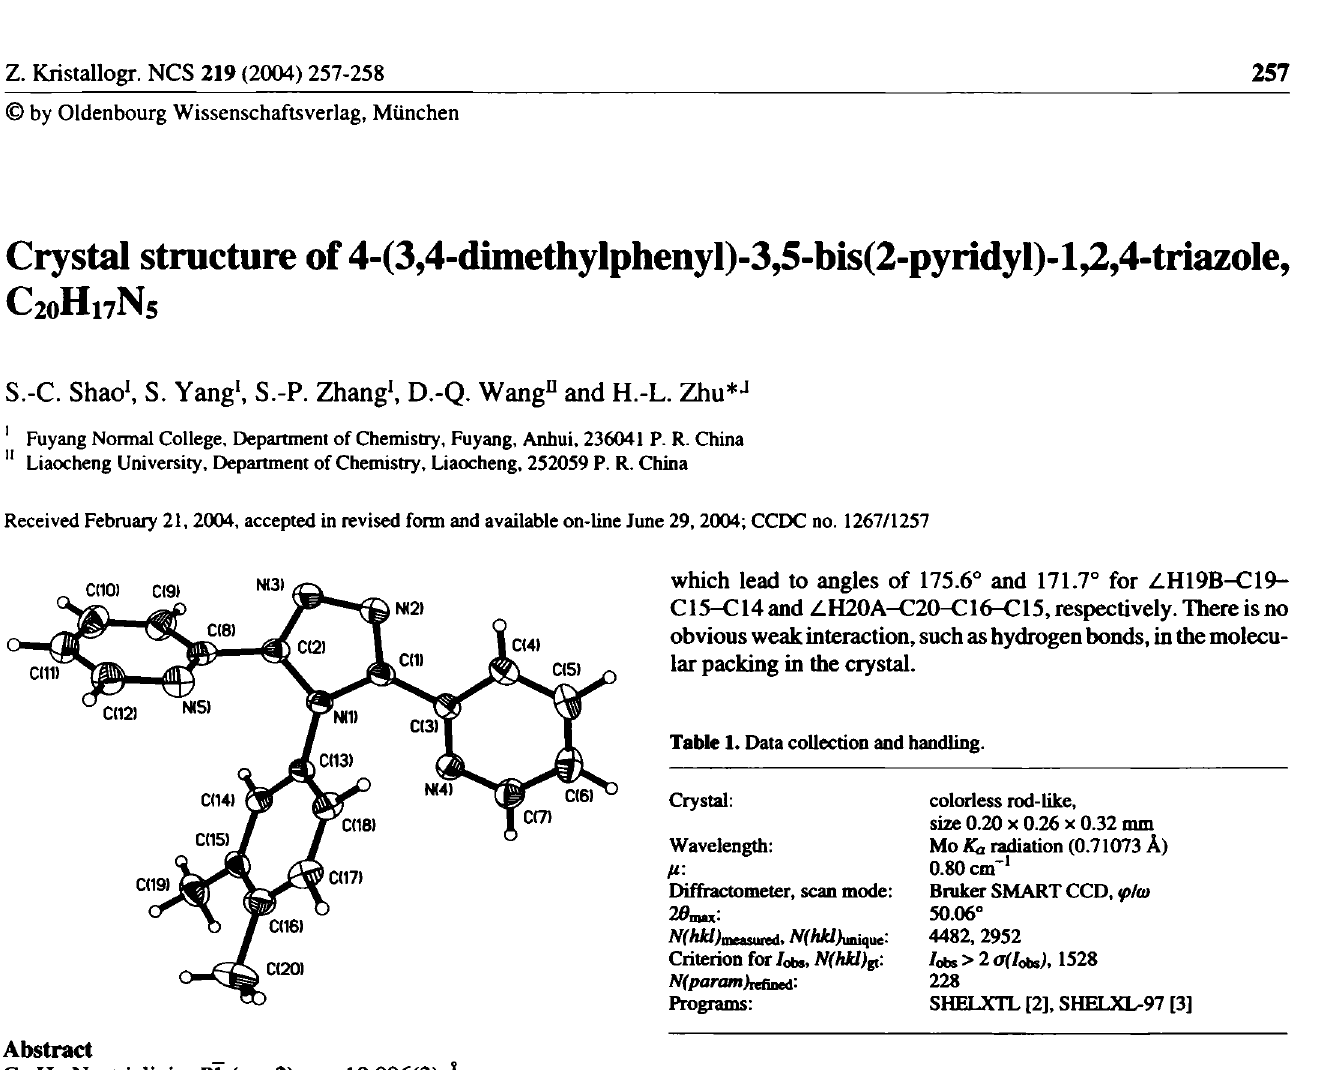
Table 2. Atomic coordinates and displacement parameters (in Â 2